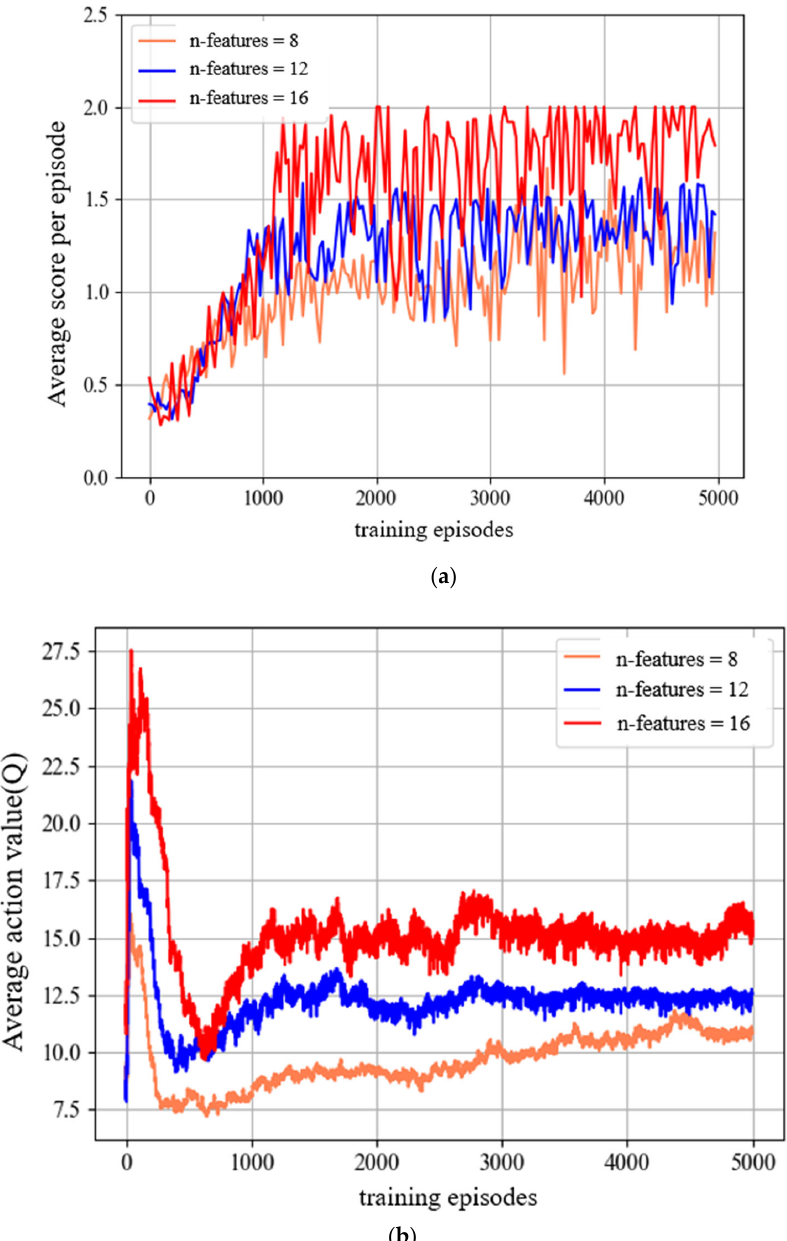
Figure 5. Average reward and average Q value under different state dimensions: ( a ) Average reward; ( b ) Average Q value.